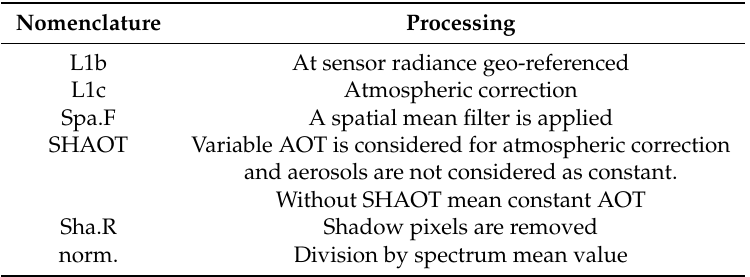
Figure 2. Pathways of the processing workflows presented in this paper. Green, red and orange correspond to georeferenced (at sensor radiance), basic atmospheric correction and enhanced atmospheric correction using SHAOT data, respectively. Table 2. Nomenclatures for each